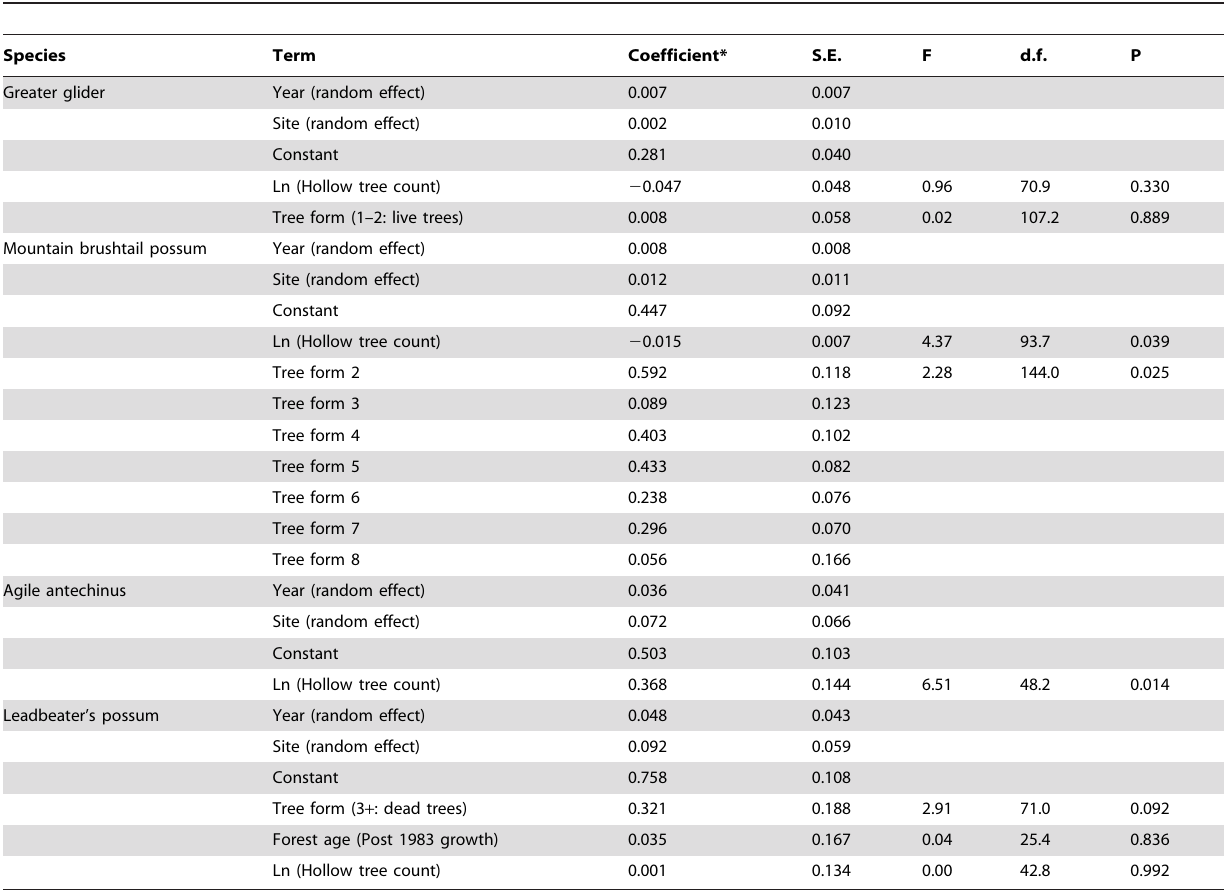
Table 3. Poisson generalised linear mixed models of the number of animals in each occupied hollow